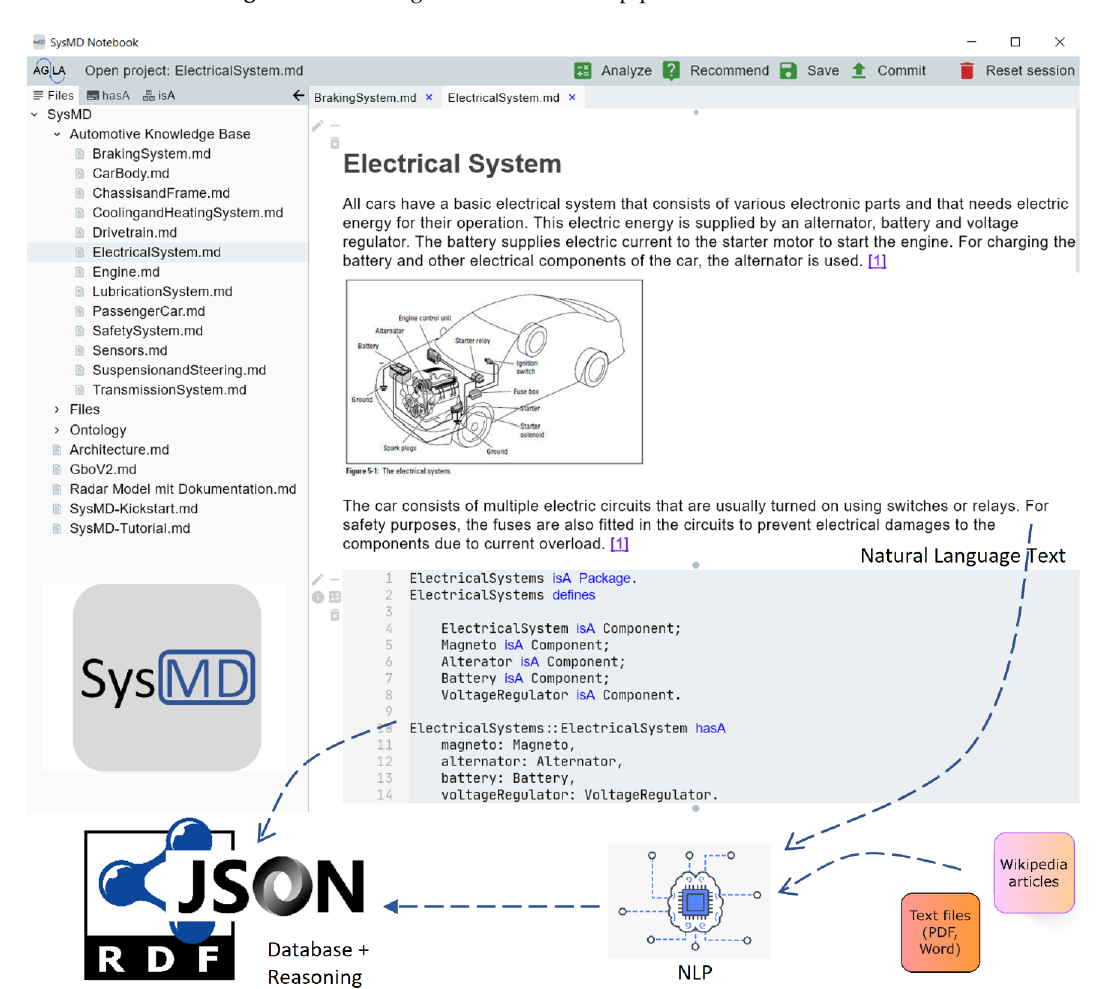
Figure 1. Knowledge-base construction pipeline.